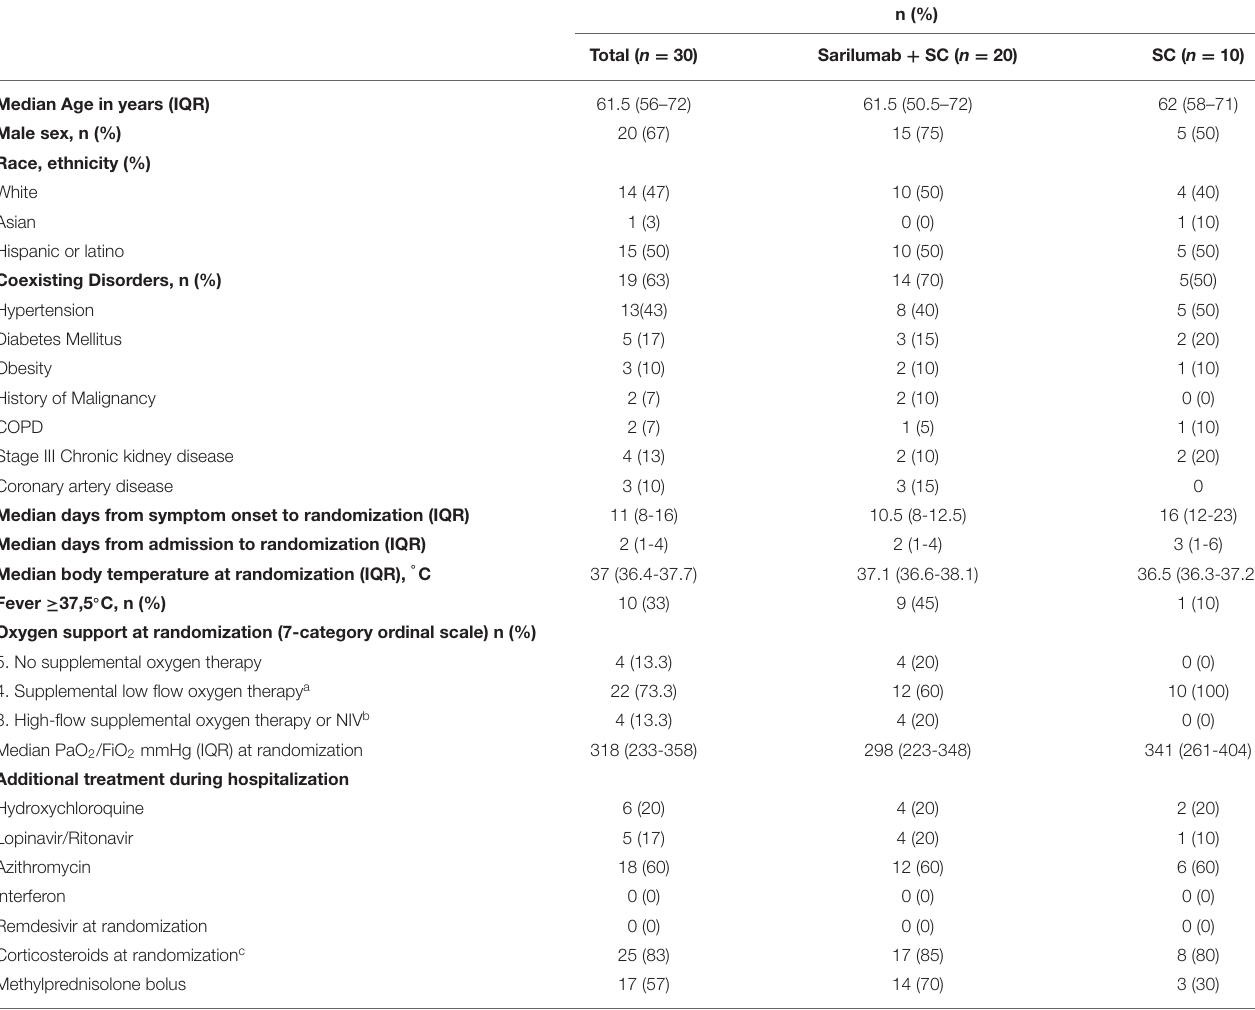
TABLE 1 | Baseline demographics and clinical characteristics of the study